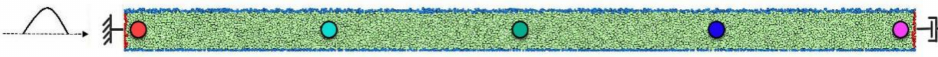
Figure 5. Setting the viscous boundary on the right reflecting boundary.